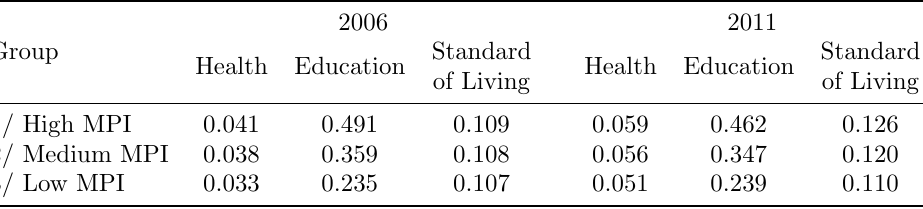
Table 5: Calculated dimensional specific MPI values for each group